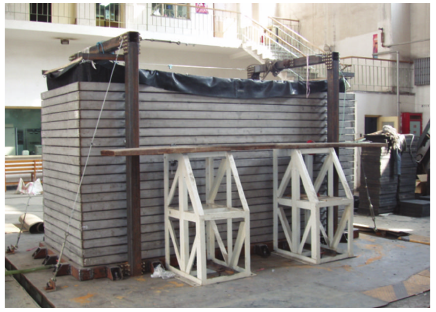
Figure 2: Design of large-scale laminar shear box.